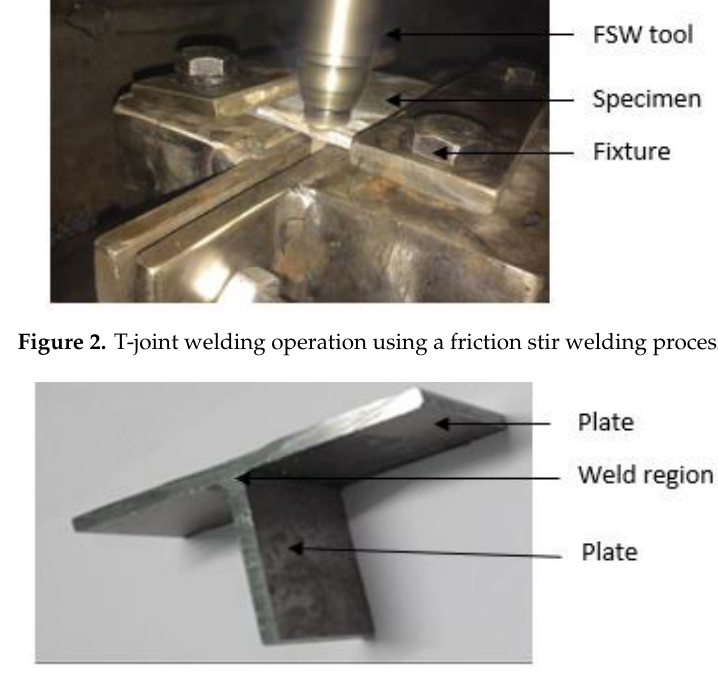
Figure 3. Welded tensile test specimens.